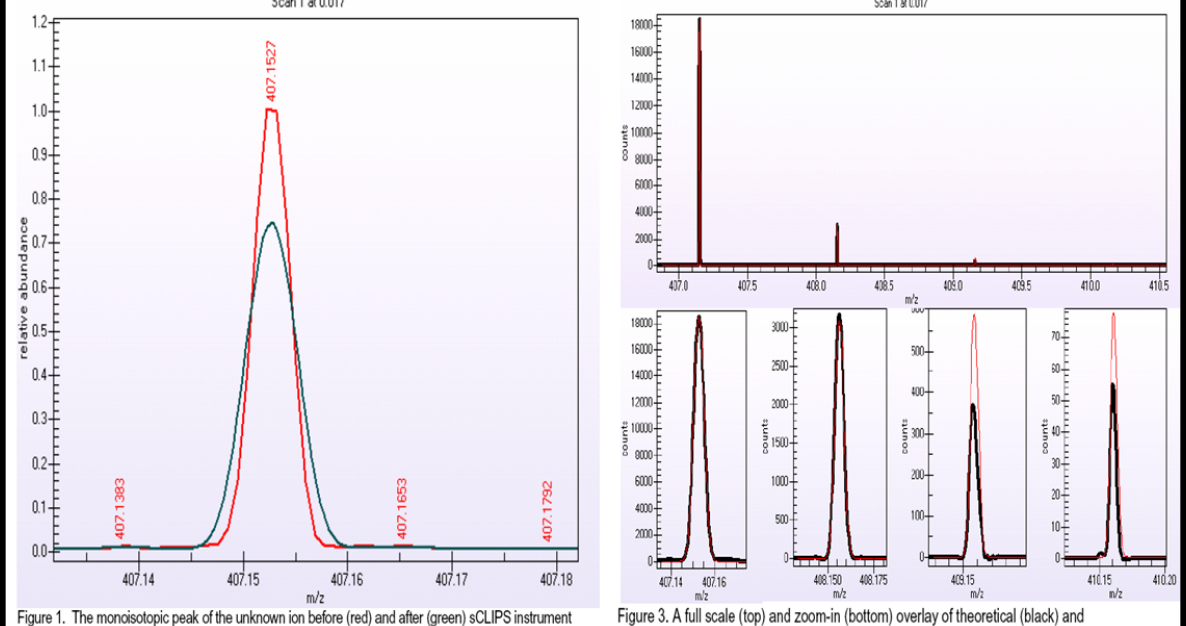
Figure 10. The unique elemental composition of m/z 407.1527 was assigned as C using Mass Works TM based on LC-MS data acquired using HPLC-LTQ FT Ultra MS at 100,000